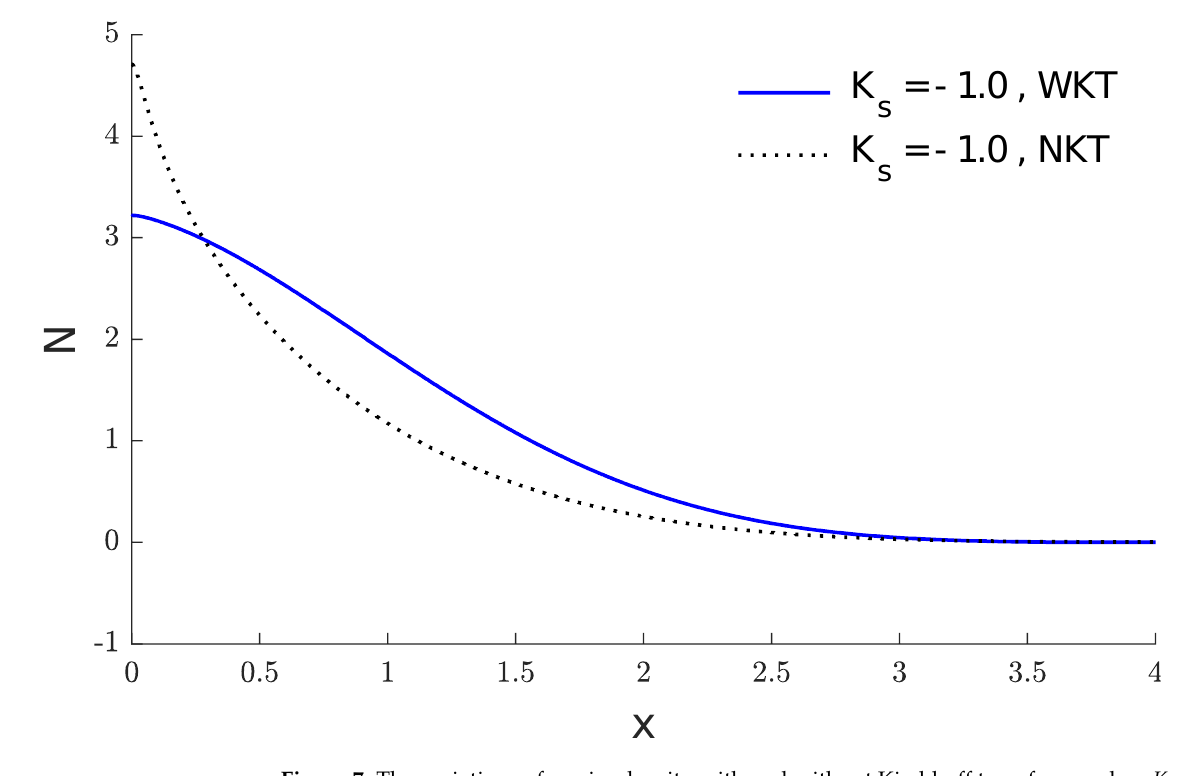
Figure 7. The variations of carrier density with and without Kirchhoff transforms when 𝐾 𝑠 = −1 .